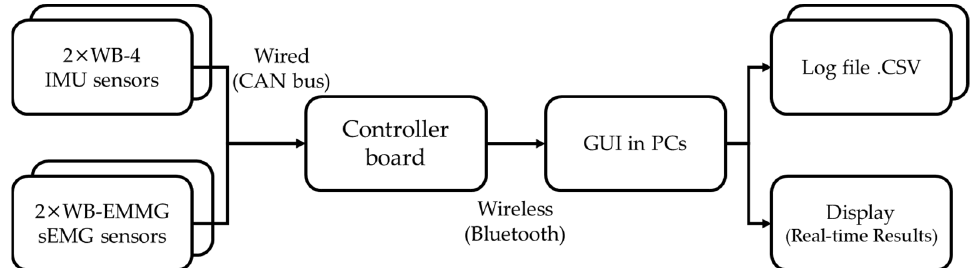
Figure 3. Measurement system using in the experiment.